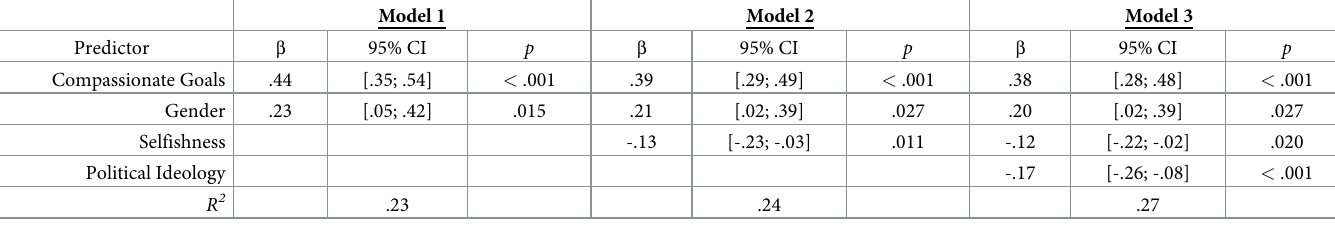
Table 2. Coefficients from multiple regression models predicting COVID-19 health behaviors in Study 1.